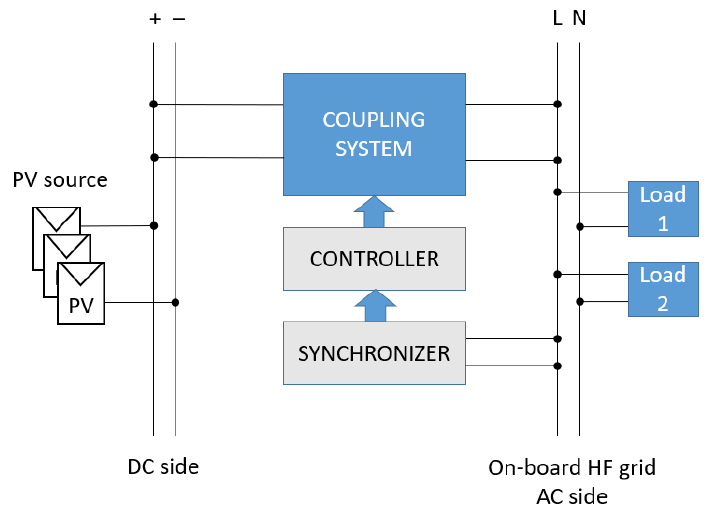
Figure 1. The coupling system structure of DC power source side with on-board high frequency